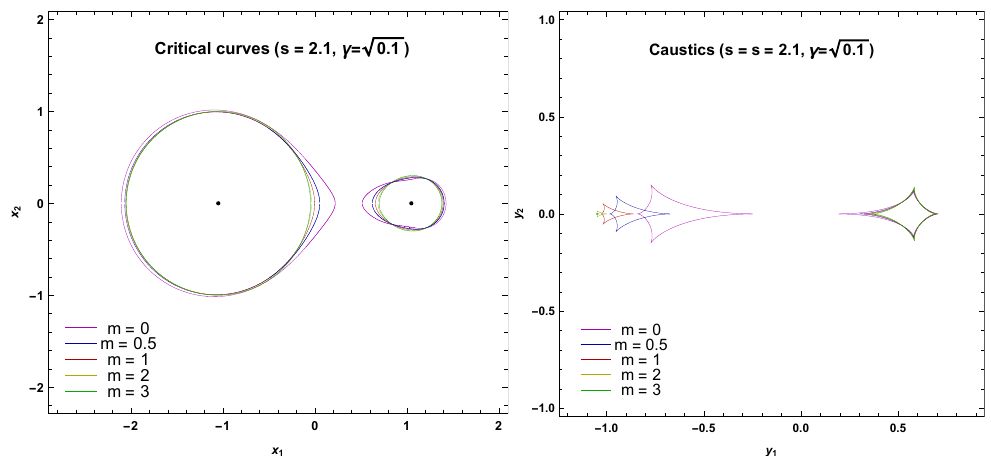
Figure 7. Critical curves and caustics in the unequal-strength binary, wide separation. Here and in the following figures the lens on the left has n = 1 and the lens on the right has variable m .